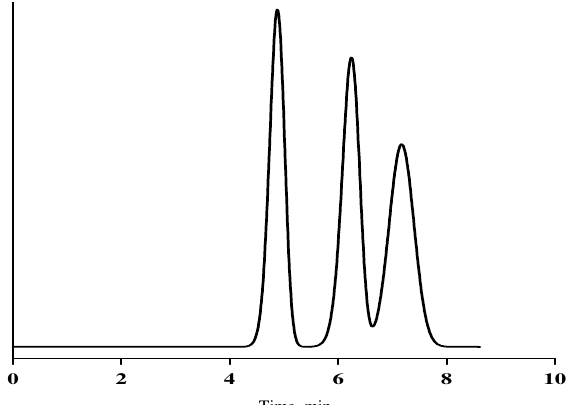
Figure 2. Chromatogram of pinazipam, clotiazepam and clozapine eluted with 0.13 M SDS- 2.4%